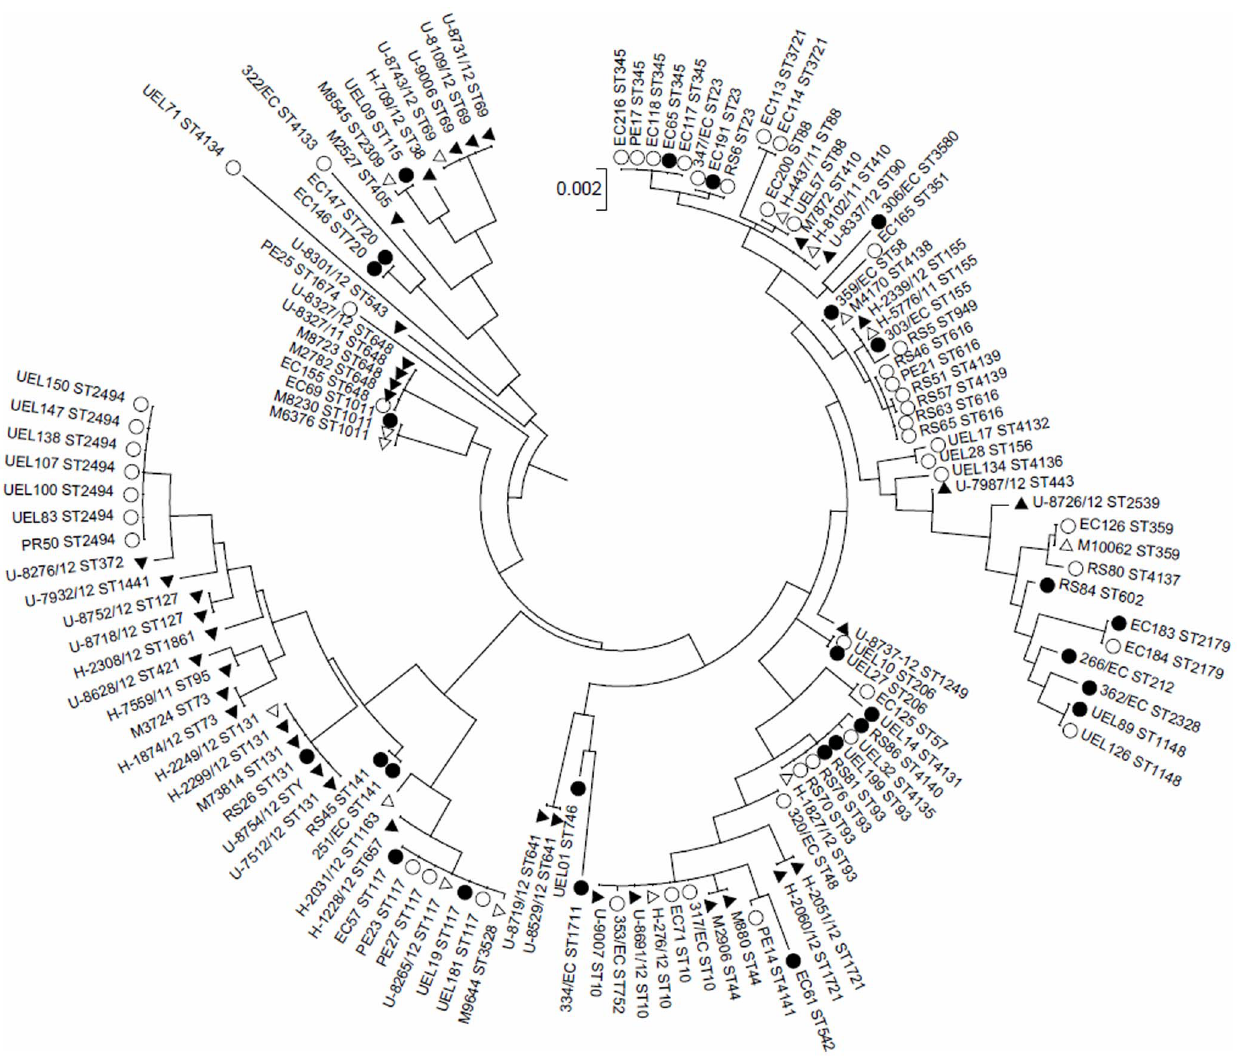
Figure 2. Molecular Phylogenetic analysis of APEC (n=76) and human ExPEC (n=53) based on concatenated MLST alleles. The evolutionary history was inferred by using the Maximum Likelihood method based on the Tamura-Nei model [22]. The tree with the highest log likelihood is shown. Circles represent APEC strains and triangles human ExPEC strains. Black geometrical shapes indicate that strains belonged to the major cluster A and white ones show that they are contained in major cluster B (see Figure 1 for more details).